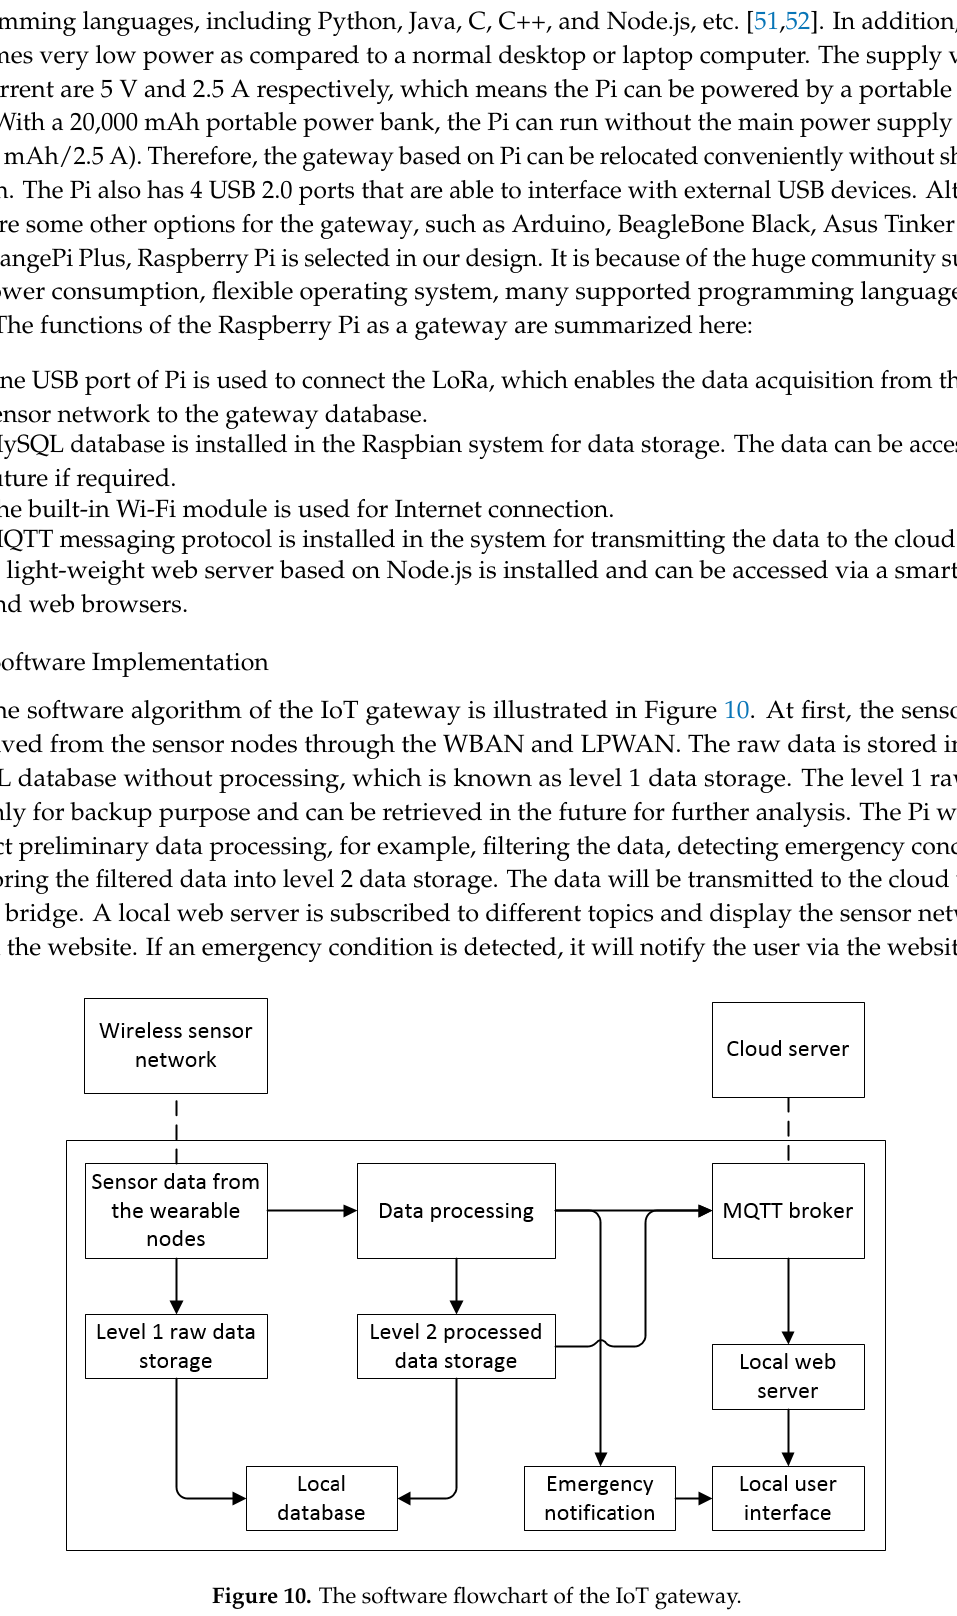
Figure 10. The software flowchart of the IoT